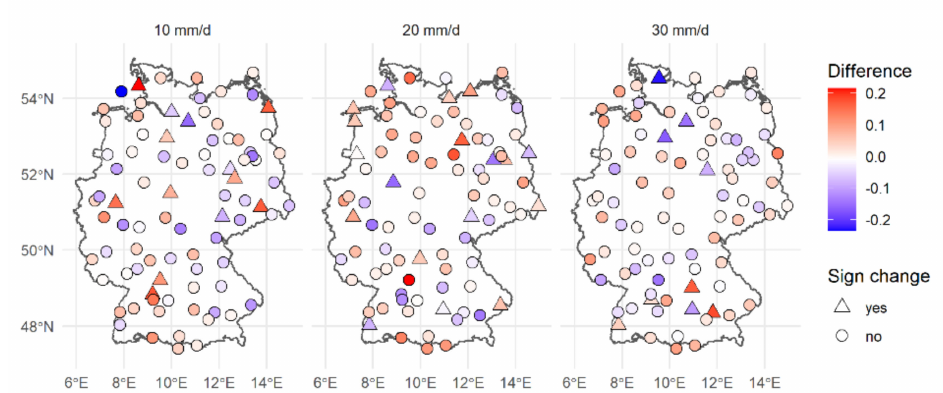
Figure 5. The strength and direction of Kendall’s tau derived from daily sums starting at 6:00 UTC compared to 8:00